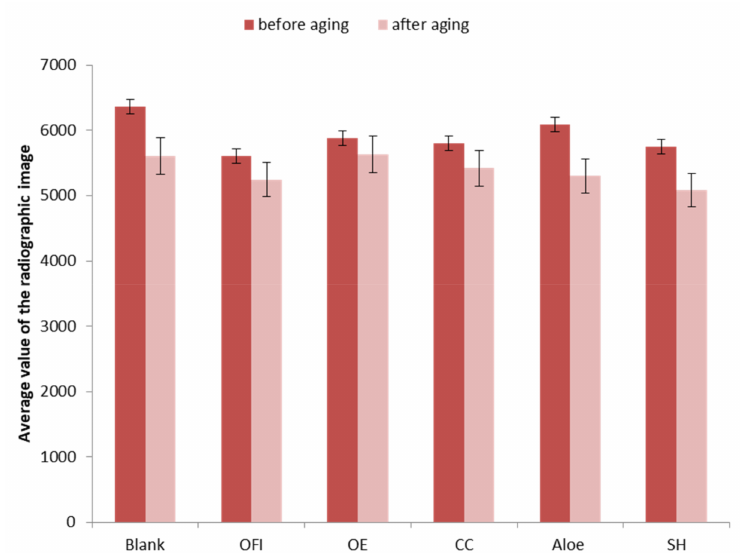
Figure 4. Radiographic density measurements before (dark red) and after (light red) 3 years of natural aging. The bars represent the standard error. Opuntia ficus-indica (OFI), Opuntia engelmannii (OE), Cylindropuntia californica (CC), Aloe vera (Aloe) and Salvia hispanica